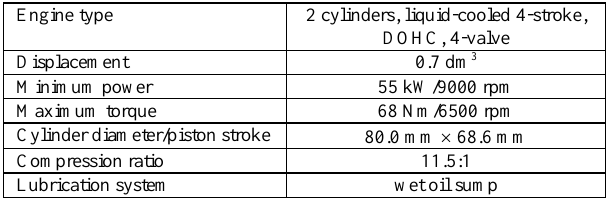
Table 1. Test motorcycle operating